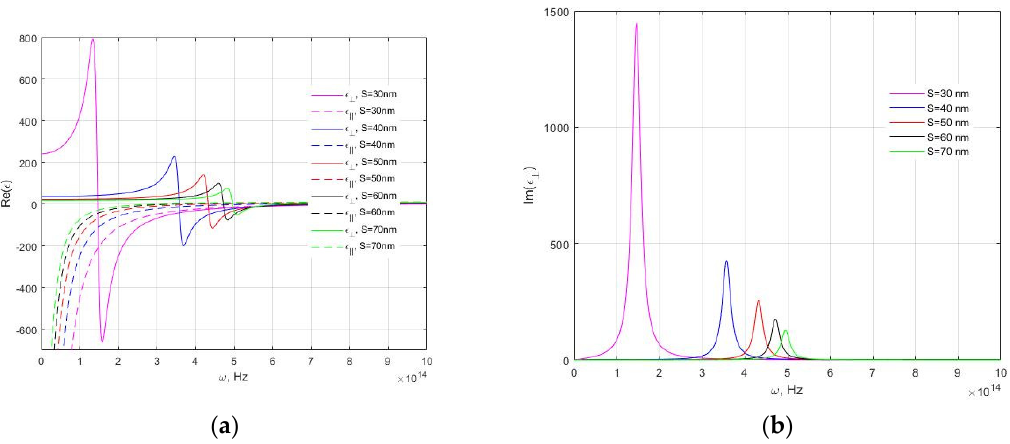
Figure 3. ( a ) Dependences of the real parts of the perpendicular and parallel permittivity components, upon frequency of the silver nanowire metamaterial. ( b ) Dependence of the imaginary part of the perpendicular permittivity component, upon frequency. d = 30 nm.